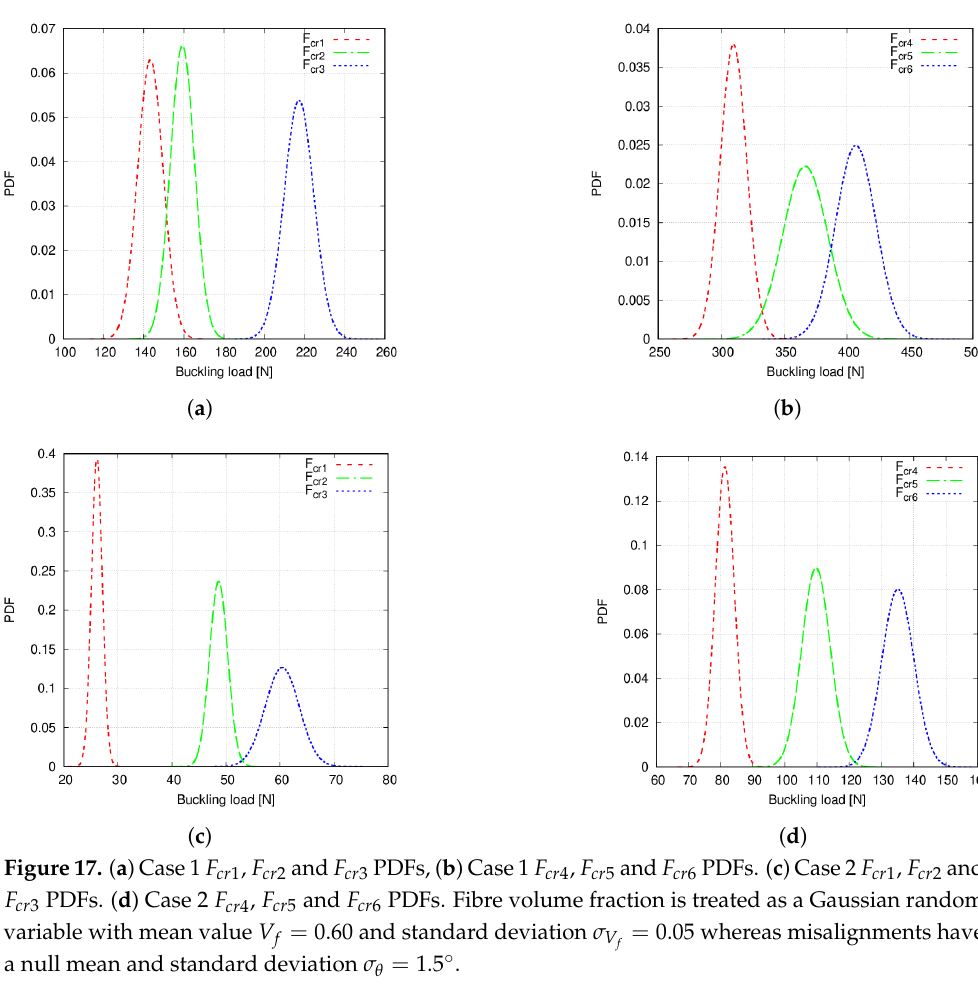
Figure 17. These PDFs were obtained using the second-order PCE surrogate and computing a total of 10 4 emulations.